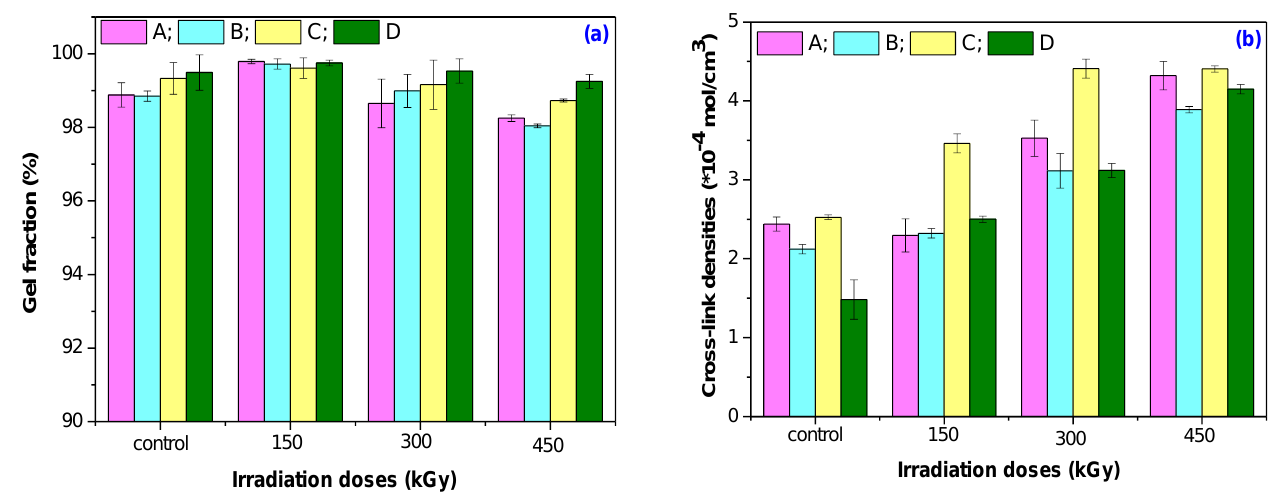
Figure 1. Gel fraction ( a ) and cross-link density ( b ) variation as a function of EB irradiation dose and mixture type. Table 3. M odifications of gel fraction and cross-link density percentages of the irradiated mixtures, reported to be corresponding to the non-irradiated sample.